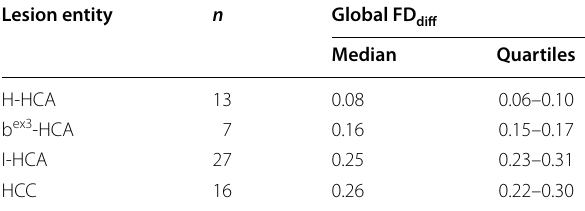
Table 3 Results of global fractal